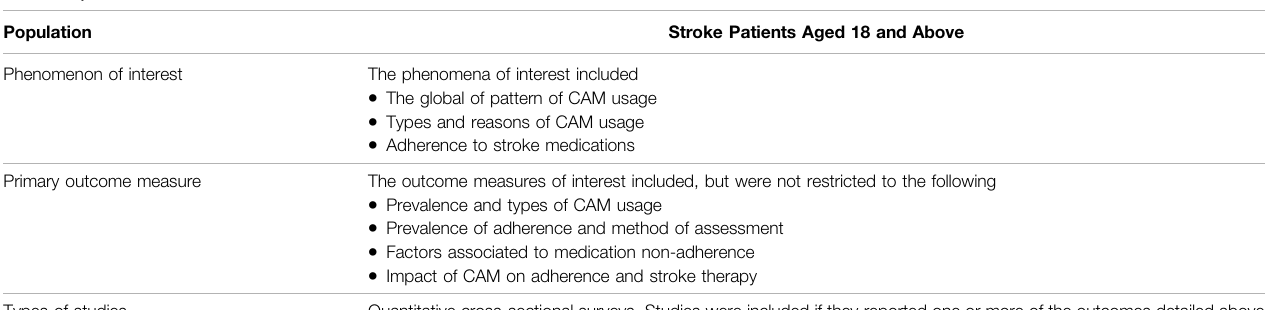
TABLE 1 | Criteria for inclusion and exclusion of studies in the